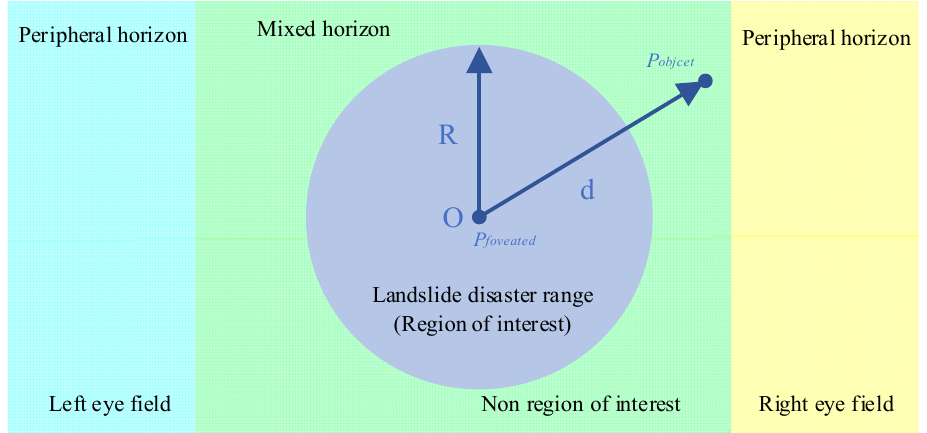
Figure 3. Division of interest areas for landslide disaster